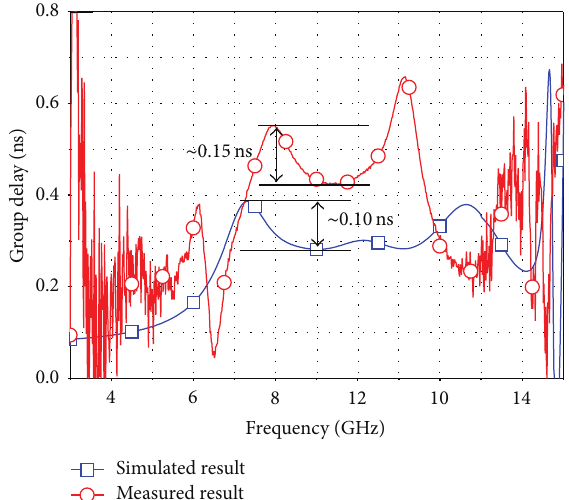
Figure 10: Comparison between measured and simulated group delay of proposed HMSW-DGS